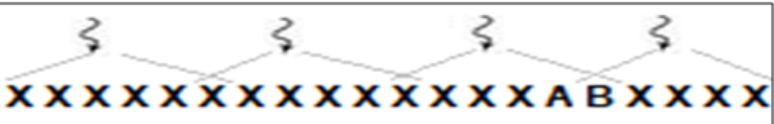
Figure 4: Threads with overlapped data to search through.